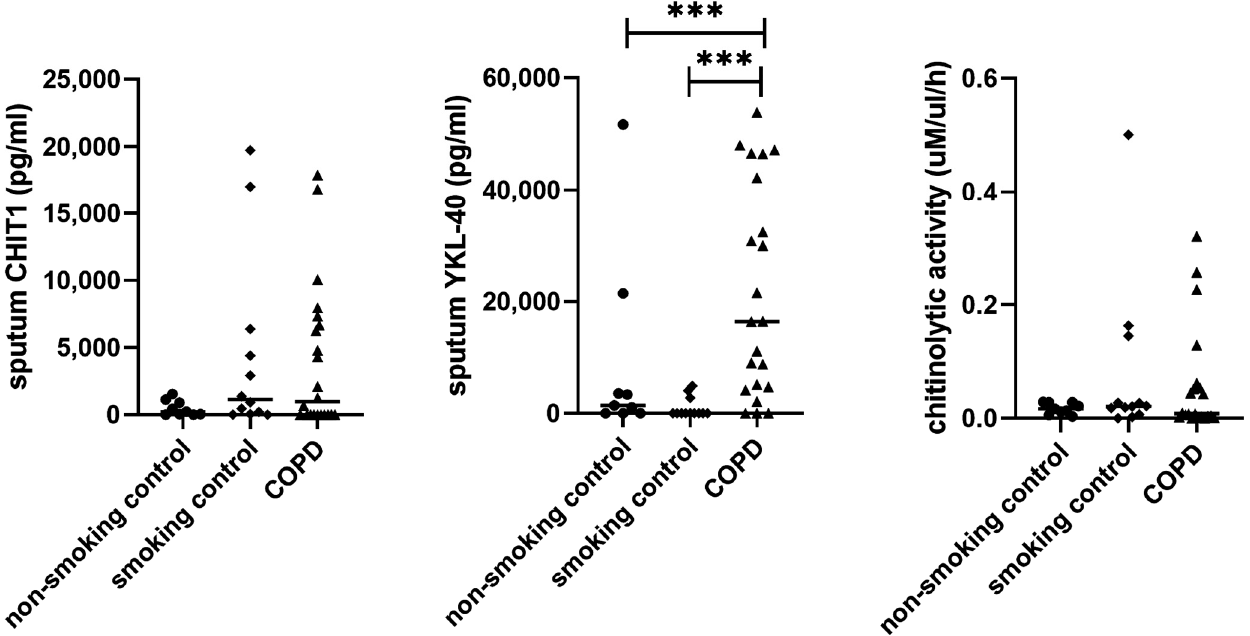
Figure 1. Induced sputum CHIT1 and YKL-40 concentrations and chitinolytic activity in COPD and control groups. Data are presented as median and individual values. Each data point represents a single individual categorized as follows: • represents cases from non-smoking control, (cid:4) represents cases from smoking control and (cid:78) represents COPD cases. *** p ≤